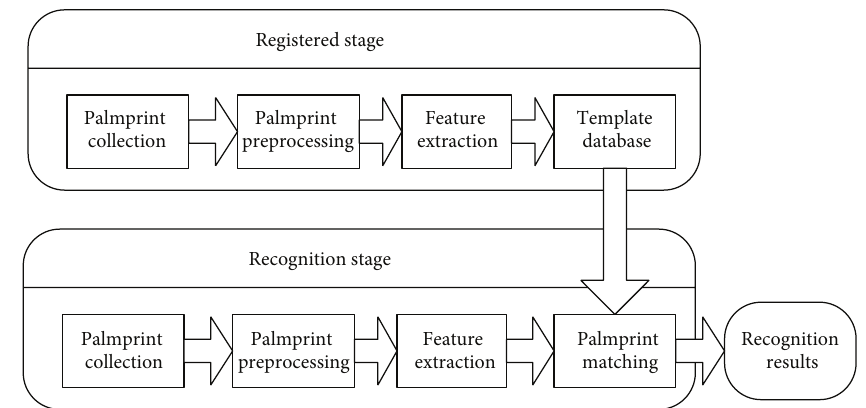
Figure 1: Flow chart of palmprint recognition.